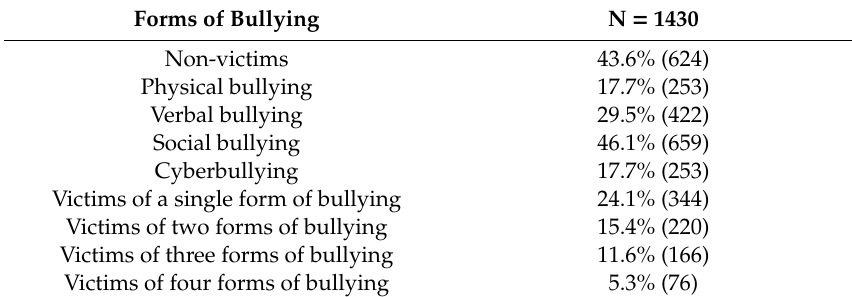
Table 1. Prevalence of each bullying victimization form and poly-bullying victims among Spanish university